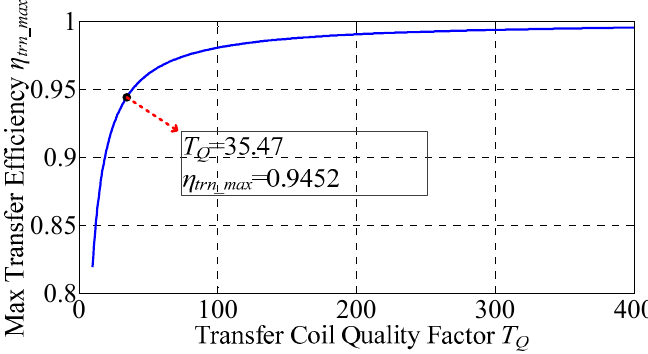
Figure 5. Curve of the maximum efficiency vs. T Q .